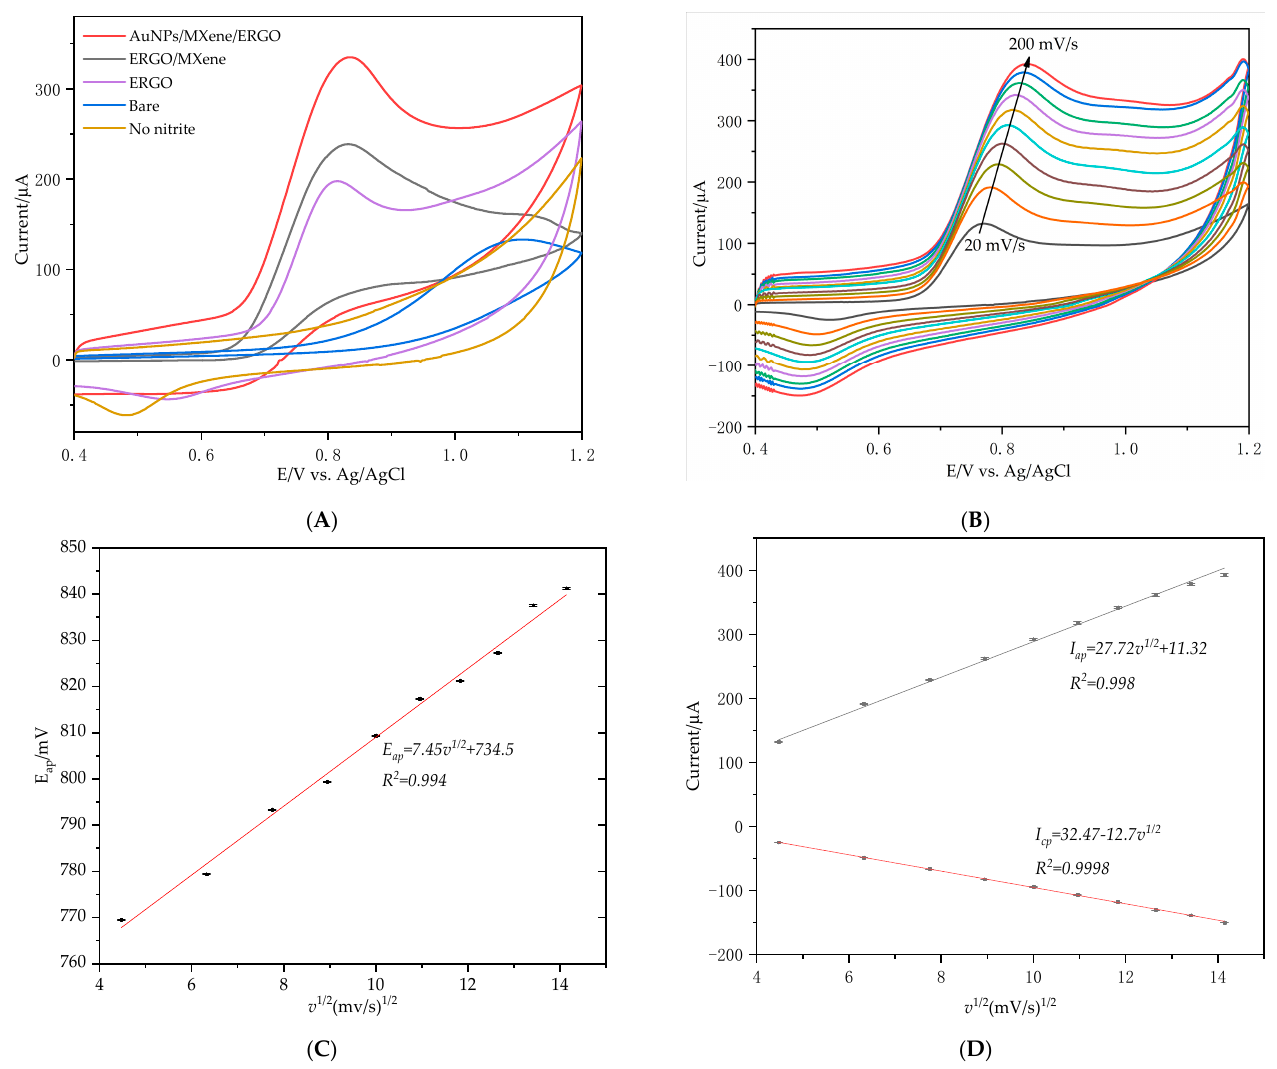
Figure 5. ( A ) CV result for Bare GCE, ERGO/GCE, ERGO/MXene/GCE and AuNPs/MXene/ERGO/GCE in 0.1 M PBS (pH 7) containing 5 mM NaNO 2 with a scan rate of 50 mV/s, no nitrite is CV result for AuNPs/MXene/ERGO/GCE in 0.1 M PBS (pH 7) without nitrite with a scan rate of 50 mV/s. ( B ) CVs of AuNPs/MXene/ERGO/GCE in 0.1 M PBS (pH 7) containing 3 mM NaNO 2 at different scan rates( v ) from 20 to 200 mV/s ( C ) the relationship of anodic peak potentials vs. v 1/2 . ( D ) the relationship of current peak vs. v 1/2 .